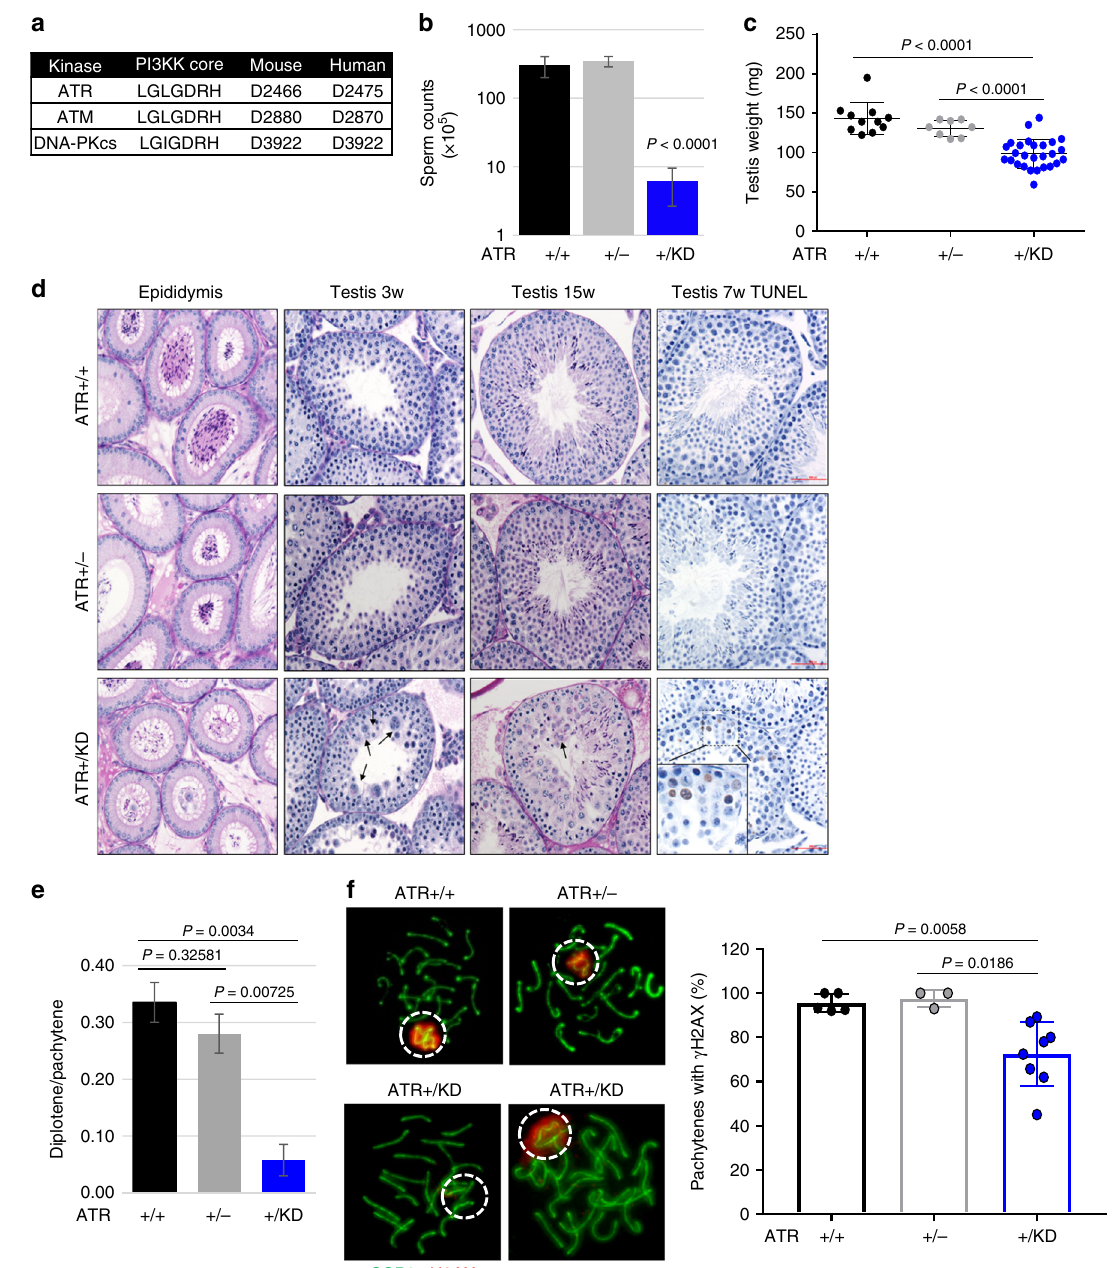
Fig. 1 Atr + /KD male mice display defects in spermatogenesis and meiotic sex chromosome inactivation. a Conservation and relative amino acid number of aspartate (D) residue in the PI3KK core of ATR, ATM, and DNA-PKcs in mouse and human. b The histogram reports the means± SD of the sperm counts derived from 6 Atr + / + , 5 Atr + / − , and 14 Atr + /KD male mice. Unpaired two-tailed t test was used. c Testes from several 12 – 37 weeks old Atr + / + , Atr + / − , and Atr + /KD mice were weighed. Mann – Whitney test was used. d Representative histological sections of H&E staining of epididymis and testis (3 weeks and 15 weeks) of Atr + / + , Atr + / − , and Atr + /KD mice. TUNEL assay was performed on 7 weeks old mice and representative images are reported. e The means ± SD of the ratio between diplotene and pachytene cells for Atr + / + , Atr + / − , and Atr + /KD mice are reported and unpaired two-tailed t test was used for the statistical analysis. f Representative SCP3 and γ H2AX immuno fl uorescence images of spermatocytes spreads are shown for Atr + / + , Atr + / − , and Atr + /KD mice. The distribution of the mean percentages of positive γ H2AX pachytenes is reported. A total of 587, 214, and 647 pachytenes were analyzed from 5 Atr + / + , 3 Atr + / − , and 8 Atr + /KD mice, respectively. Unpaired two-tailed t test was used for the statistical analysis. Source data are provided as